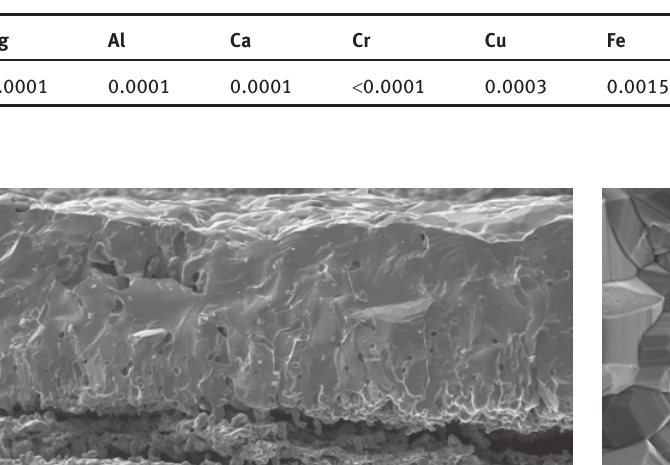
Table 1: Impurities in Ni starting material (wt%).